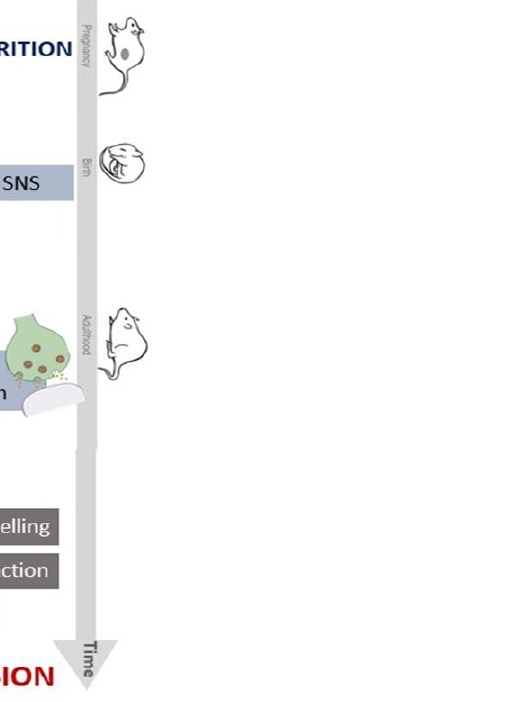
Figure 7. Effect of suboptimal foetal undernutrition on SNS and vascular wall from a rat FPH model.